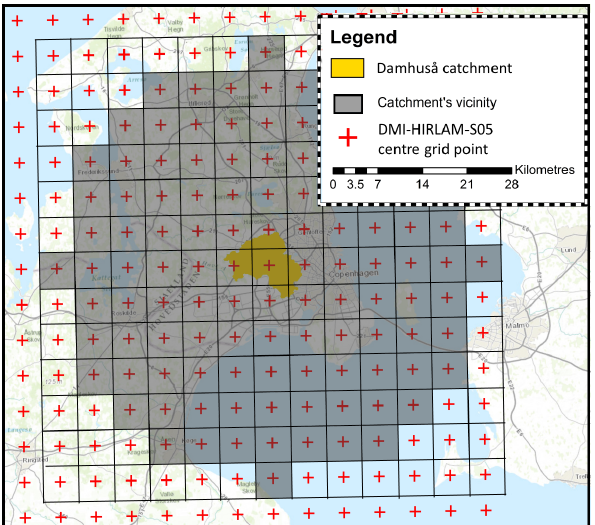
Figure 2. Illustration of the 6-grid-cell radius used by the maximal threat neighbourhood approach, for the Damhuså catchment used for demonstration in this paper (Courdent et al.,